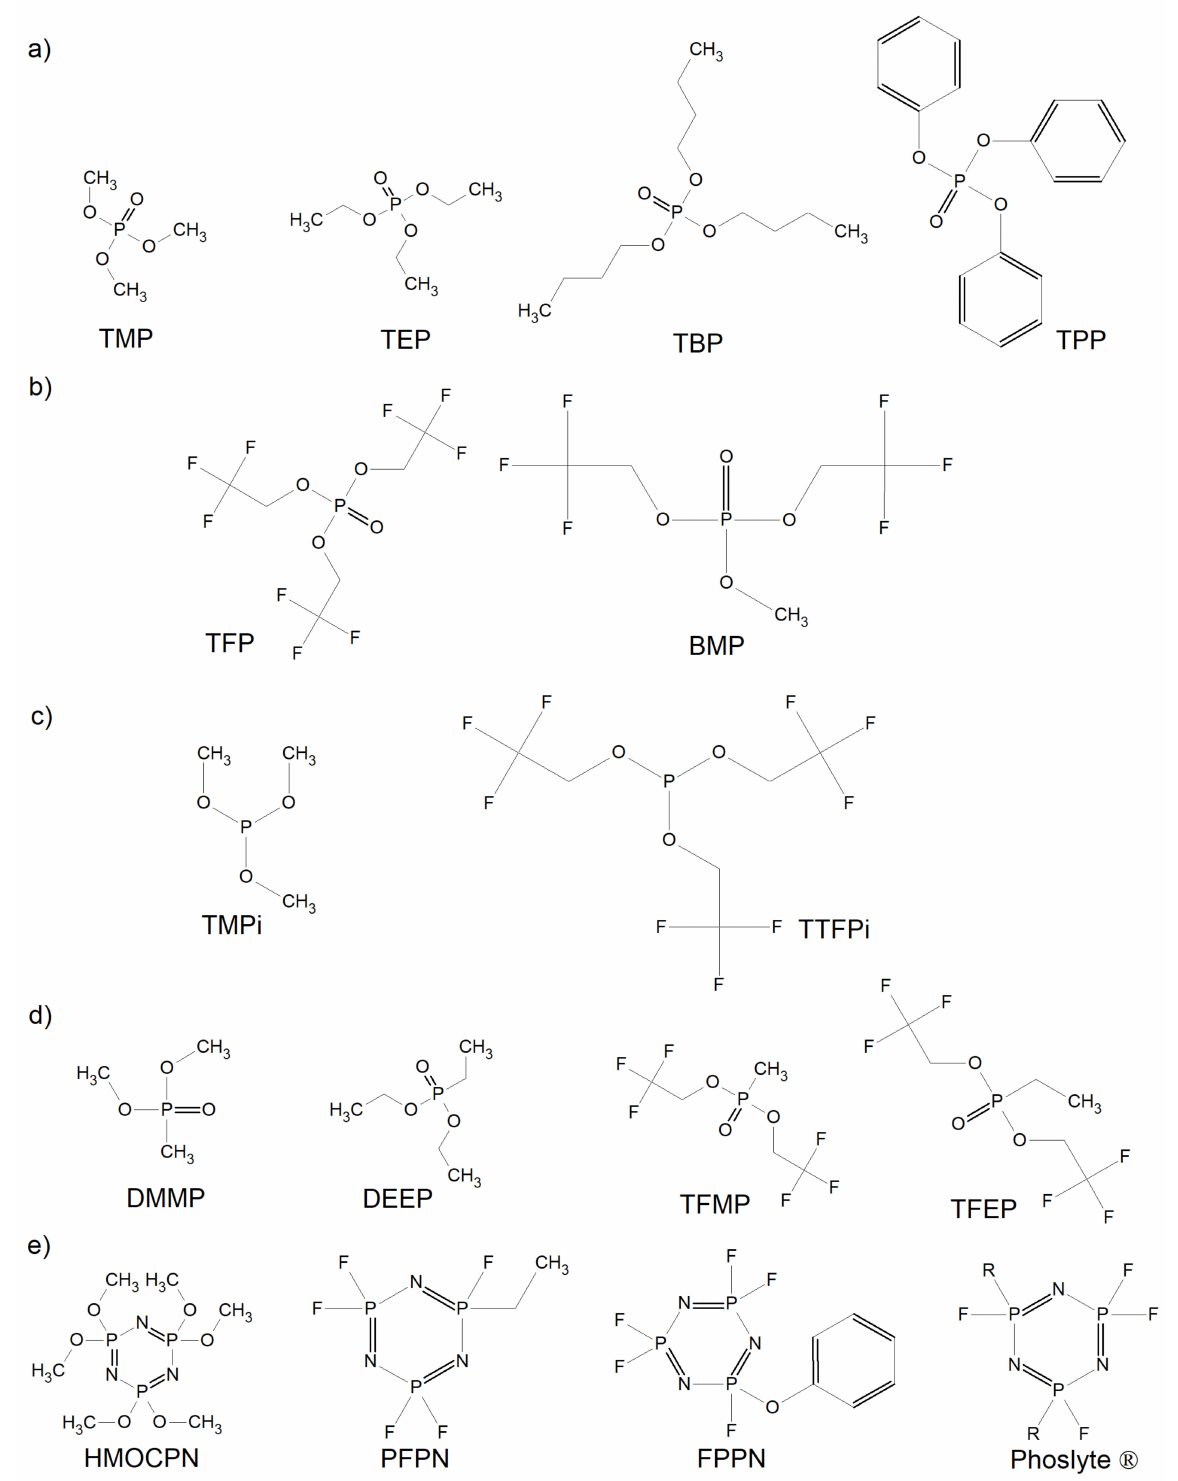
Figure 7. Molecular structures of ( a ) phosphates; ( b ) fluorinated phosphates; ( c ) phosphites; ( d ) phosphonates; and ( e ) cyclophosphazenes used as flame retardants in